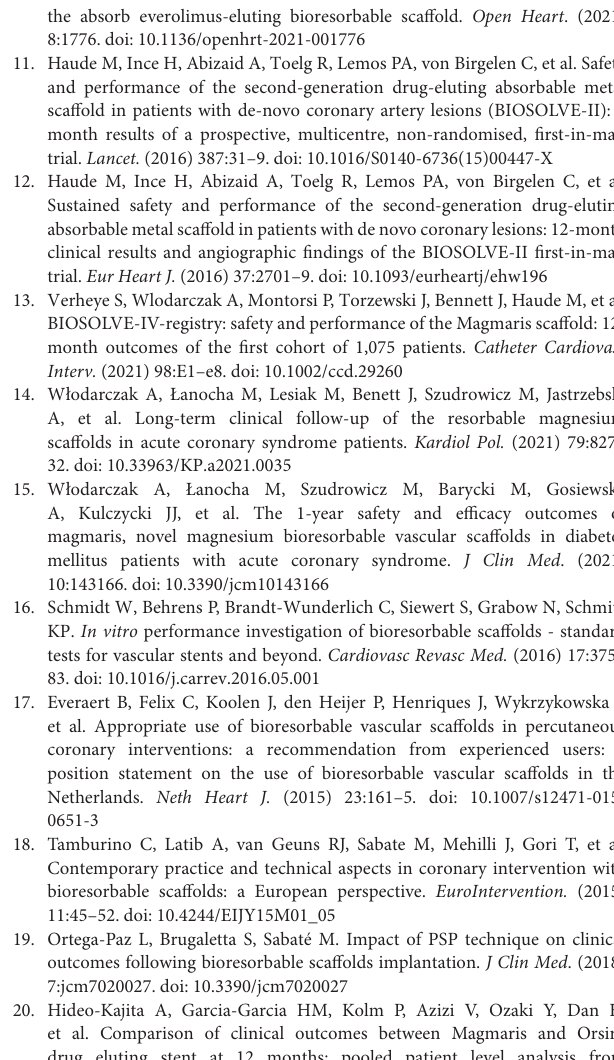
Supplementary Figure 2 | Angiographic presentation of a patient with the Mg-BRS-related ScT. (A–C) Patient undergoing percutaneous coronary intervention (PCI) of a significant lesion of the mid LAD artery (90% stenosis, arrow ): (A) Initial angiogram ( ∗ lesion before PCI). (B) Final angiogram after the Mg-BRS implantation and postdilatation ( † lesion after treatment). (C) Angiogram at presentation with ScT ( ‡ ). Mg-BRS, magnesium-based sirolimus-eluting bioresorbable scaffold; ScT, scaffold thrombosis. Supplementary Table 1 | Independent predictors for DoCE. Data are mean reported as hazard ratio (HR) and 95% confidence interval (CI). ACS, acute